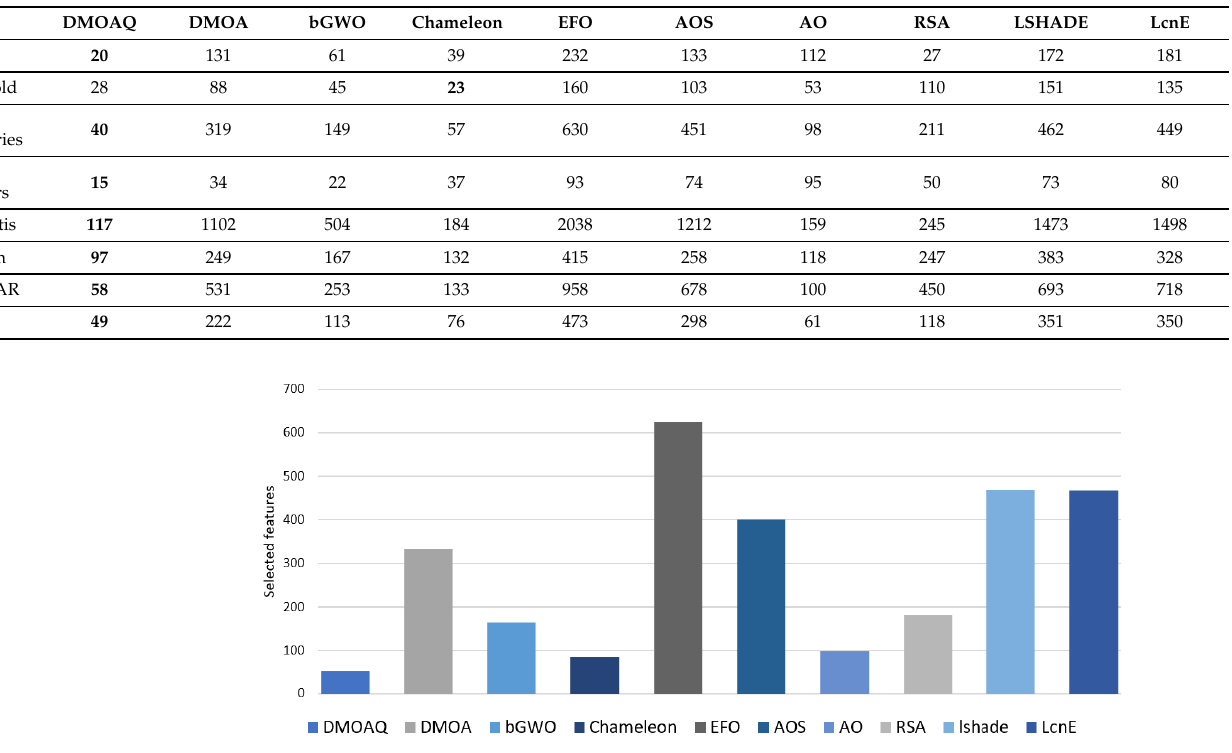
Figure 8. Ratio of the selected features for all